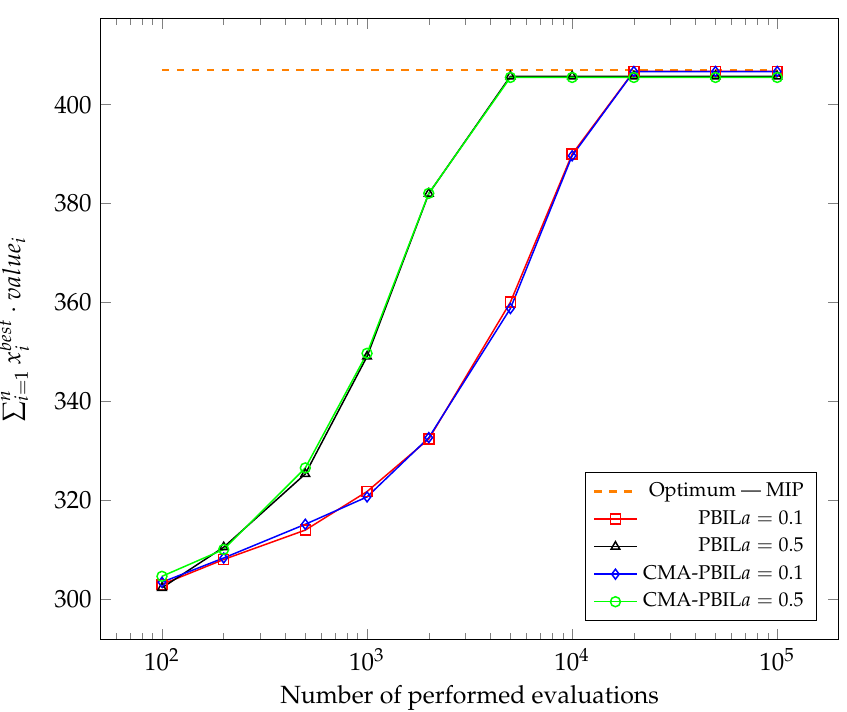
Figure 4. The average of the maximal values of the objective function calculated so far, test case no 4.